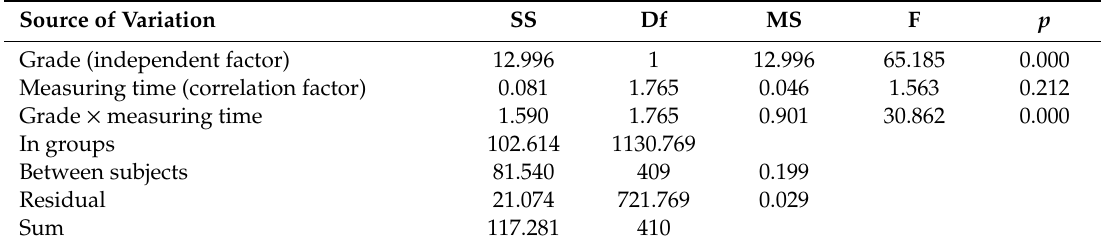
Table 6. Two-factor mixed-design ANOVA results for right eye visual